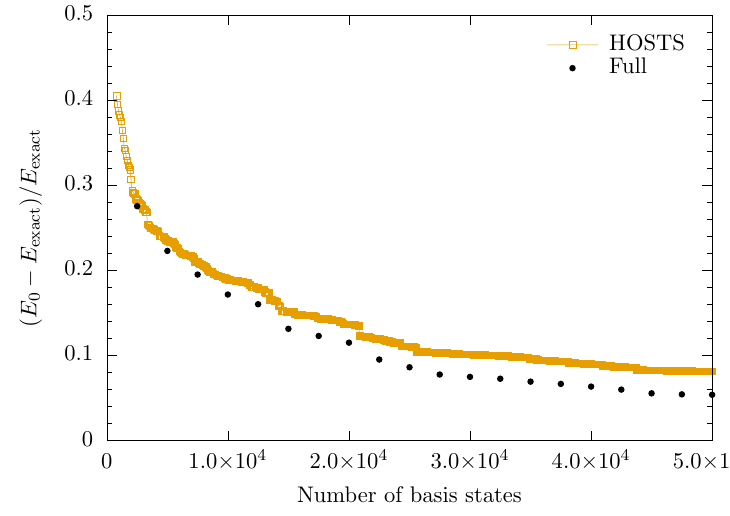
Figure 17: An example calculation showing that for strongly non-perturbative quenches there can be a large discrepancy between the results from full diagonal- isation and the NRG-extension of HOSTS. We consider the c quench for N = 6 particles, cf. Fig. 14. N + ∆ N